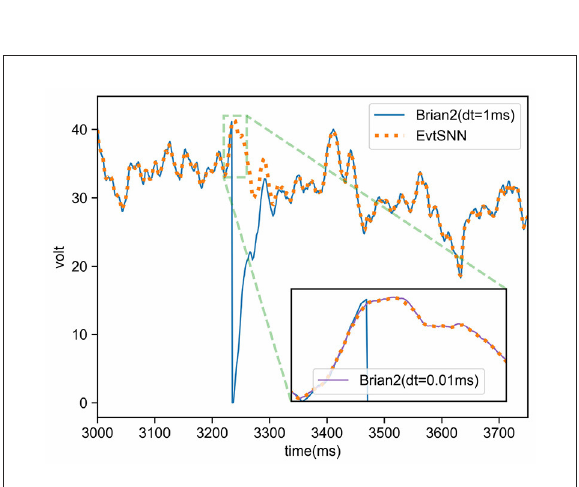
FIGURE9 Voltage curves of neurons in Brian2 and EvtSNN simulations. The clock-driven framework Brian2 has higher simulation accuracy when using smaller time steps (e.g., dt = 0.01 ms), and its voltage is close to the result of the event-driven framework EvtSNN. When using a larger time step (e.g., dt = 1 ms), the simulation accuracy of Brian2 decreases and leads to changes in the firing